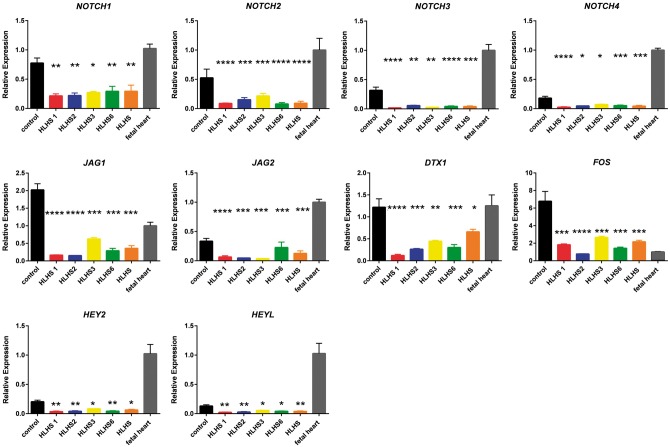
Reduced expression of key components of NOTCH signalling pathway in HLHS iPSC lines. Quantitative RT-PCR analysis performed on day 14 iPSC- derived cardiomyocytes showing decreased expression of NOTCH receptors, NOTCH ligands and targets in HLHS-iPSC-derived cardiomyocytes when compared to unaffected controls. Data are presented as mean+/- SEM. The values for fetal heart sample were set to 1 and all other values were normalised against this. One way Anova analysis with Dunnett multiple comparison tests was performed. ****P < 0.0001; ***P < 0.001; ** P value between 0.001 and 0.01 *P value between 0.01 and 0.05. HLHS iPSC lines: N = 6 (2 clones × triplicate biological repeats), control iPSC lines: N = 12 (2 clones × triplicate biological repeats × 2 unaffected control iPSC lines).